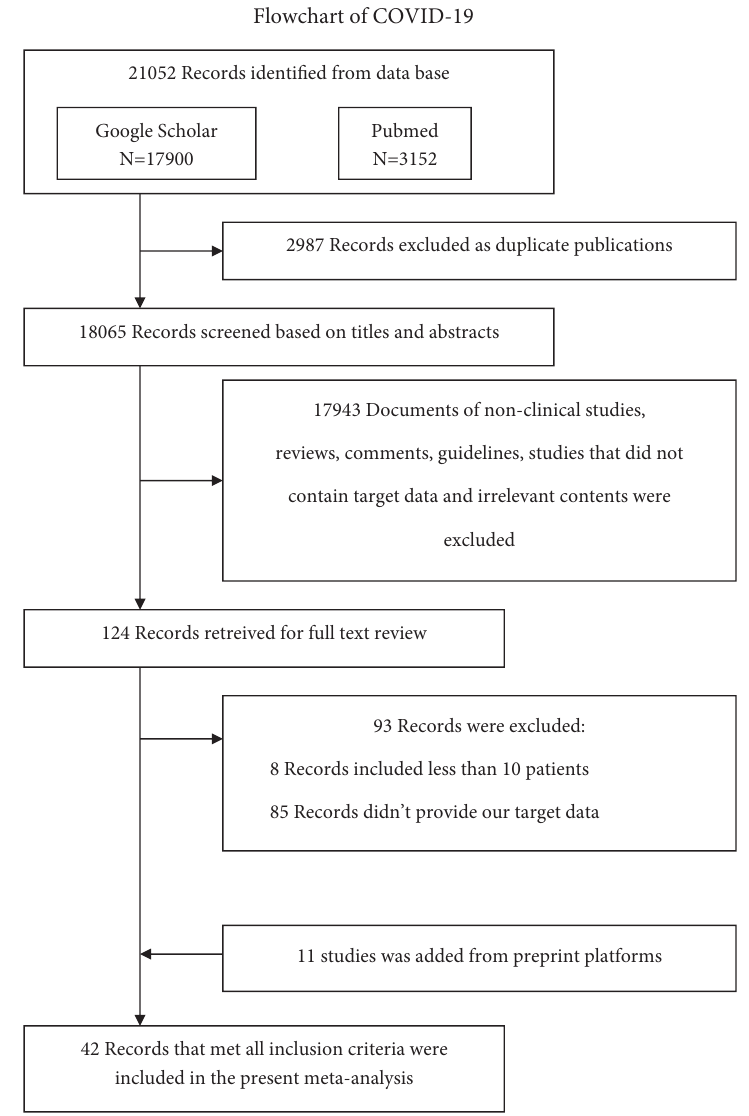
Figure 1: Flow diagram of the study selection